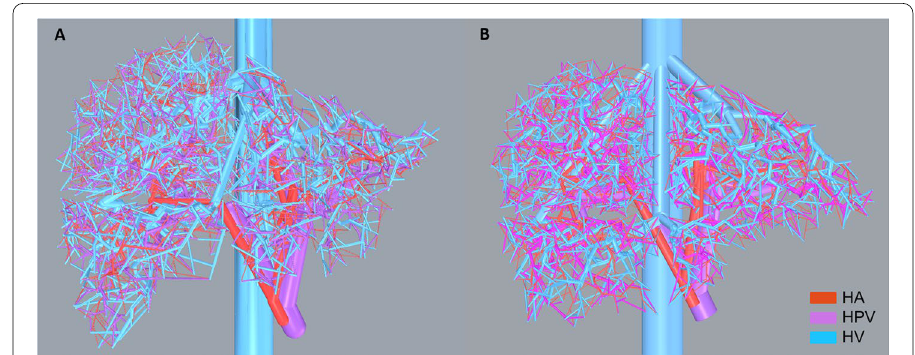
Fig. 4 Main vessels and vascular trees generated inside the A AML and the B AFL